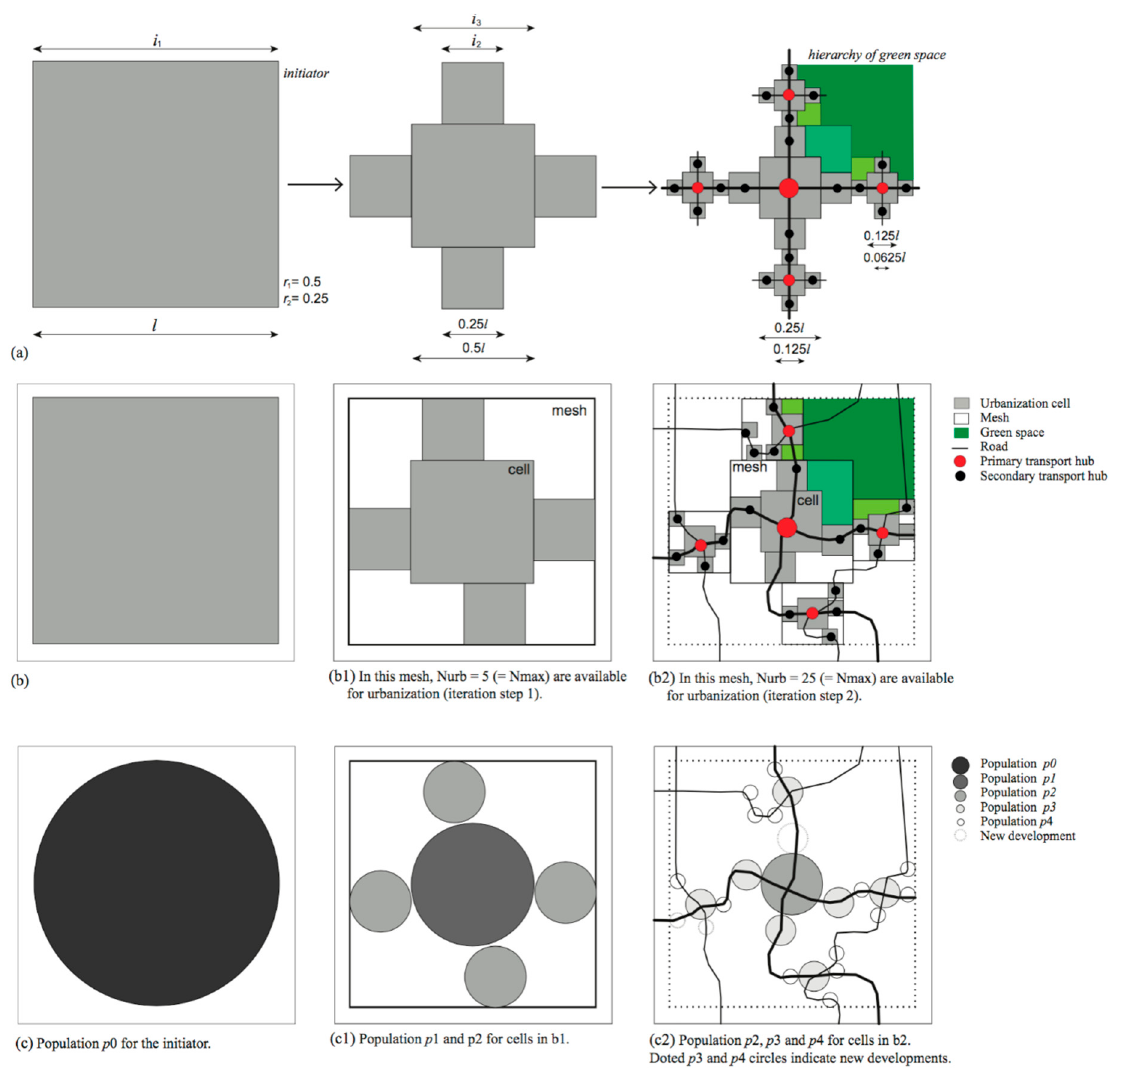
Figure 1. ( a ) a theoretical multifractal Sierpi ń ski ( b ) with different-sized centers representing urban growth along a street network axis with public transport hubs; ( c ) population distribution according to the multifractal Sierpi ń ski’s spatial hierarchy.